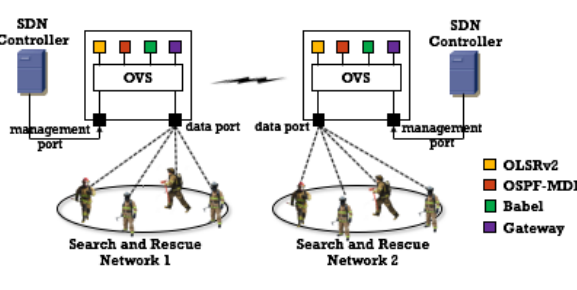
Figure 16. SDN-based Network Operations with Open vSwitch